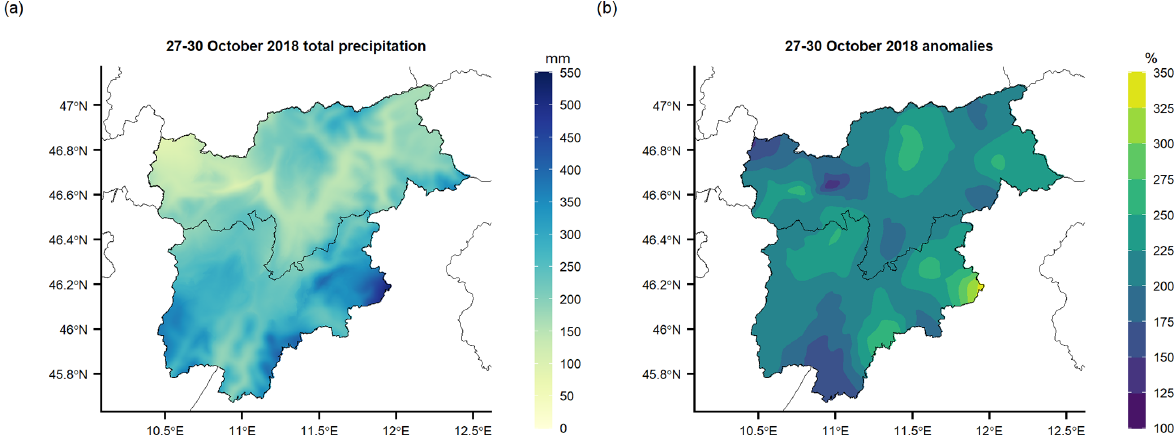
Figure 11. Event of October 2018 over Trentino-South Tyrol: (a) 4d total precipitation over 27–30 October 2018 (250m spatial resolution) and (b) relative anomalies of the 4d totals with respect to the 1981–2010 monthly normals of total precipitation for